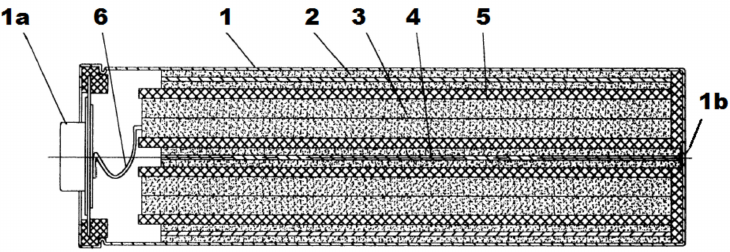
Figure 25. Schematic diagram of a high-capacity cell with 1: can, 1a: positive terminal, 1b: negative terminal, 2: negative electrode, 3: positive electrode, 4: central rod, 5: separator, and 6: current collector